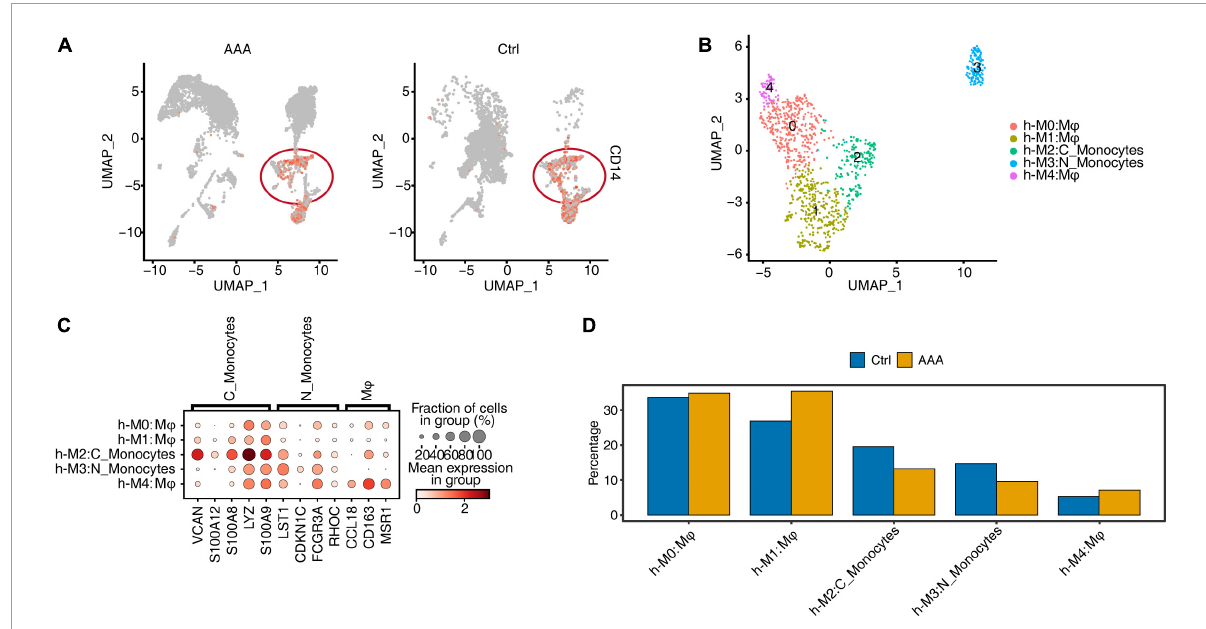
FIGURE4 Single-cell RNA sequencing (ScRNA-seq) of human abdominal aortic aneurysm (AAA) showed the increase of macrophage cells but not monocytes. (A) Gene expression level of CD14 were represented in the uniform manifold approximation and projection (UMAP) plot split by human AAA and control group. (B) UMAP plot of scRNA-seq profile from macrophages/monocytes (M ϕ /Mo) was separated into five subtypes. Cells were colored according to different cell types. C_Monocytes, classical monocytes; N_Monocytes, non-classical monocytes. (C) Dot plot showing expression of representative markers in each subtype of M ϕ /Mo. Color of dots represented the log fold change in each cluster comparing with other cells and dot size indicated percentage of cells in each cluster expressing the marker genes. (D) Bar plot comparing the proportions of cell populations of subtype of M ϕ /Mo within each sample